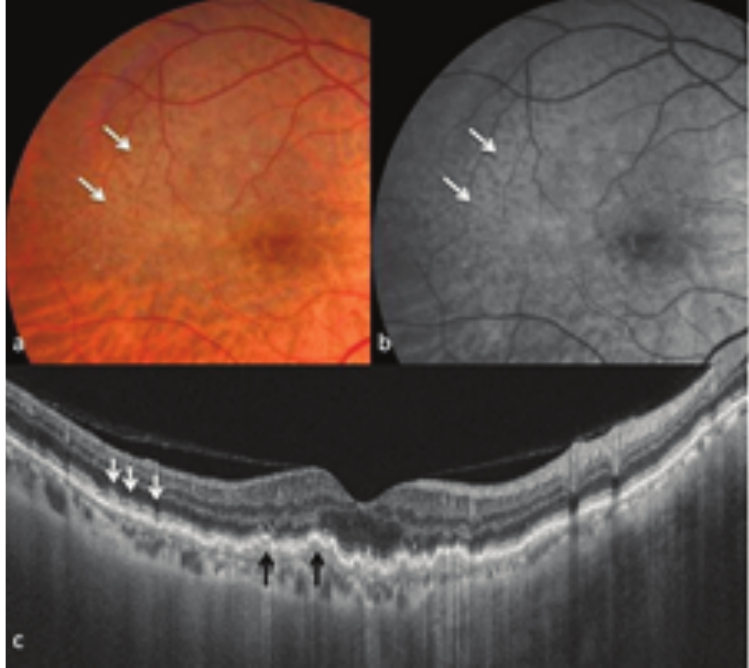
Figure 2. Multimodal imaging of a case of AMD. (a) Fundus photograph shows multiple soft drusen at the fovea with pigmentary changes suggestive of non-exudative AMD. Numerous confluent ribbon-like interlacing reticular drusen are seen predominantly in the perifoveal area in superotemporal quadrant (white arrows). (b) The reticular lesions (white arrows) are better delineated on red- free imaging. (c) The swept-source OCT through the top white arrow in subfigure “a” shows broad mound-shaped deposits in the subretinal space (white arrows) deflecting the ellipsoid zone inward suggestive of reticular drusen. The black arrows point to the sub-RPE deposits suggestive of soft drusen. The subfoveal choroid seems markedly thin with obliteration of the choriocapillaris layer.